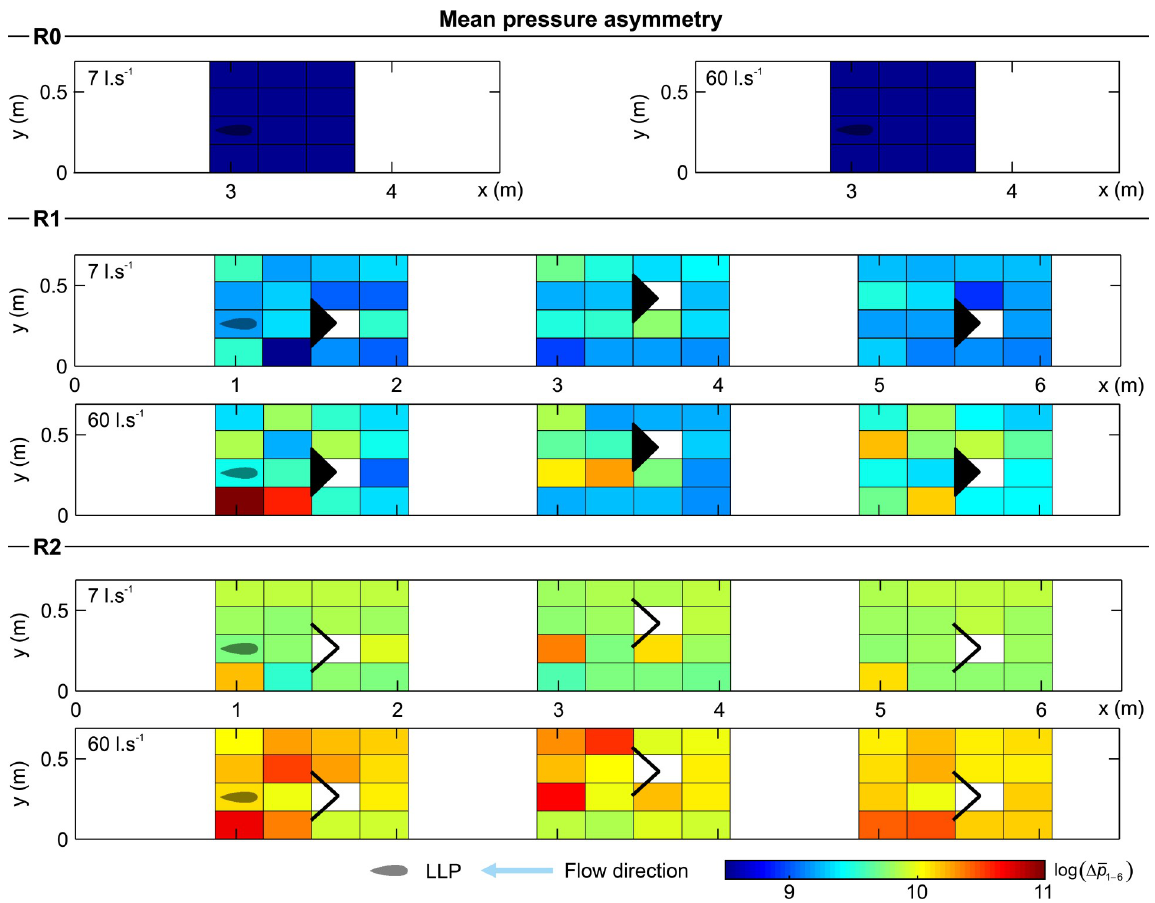
Fig 9. Distribution of mean pressure asymmetry ( D � p ) for all configurations and both discharges scenarios considered (7 and 60 l.s -1 ). 1 (cid:0) 6 The reader is referred to supporting information (S3 Fig) to look at the contour representation of this figure.